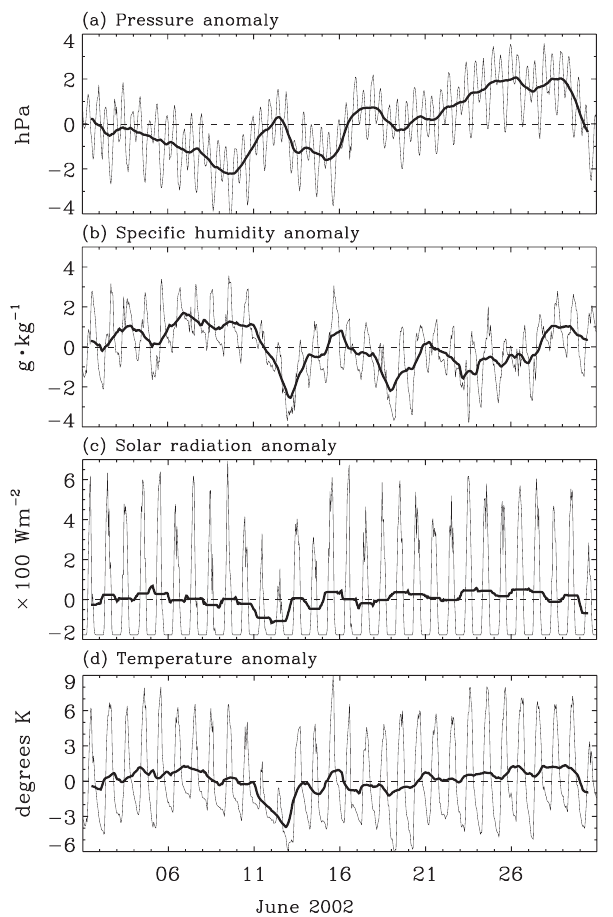
Fig. 10. Anomalies of surface (a) pressure, (b) specific humid- ity, (c) solar radiation, and (d) temperature observed at Kototabang GAW station in June 2002. Thin curves show values averaged every hour, and thick curves show smoothed values by 24-hour running mean.